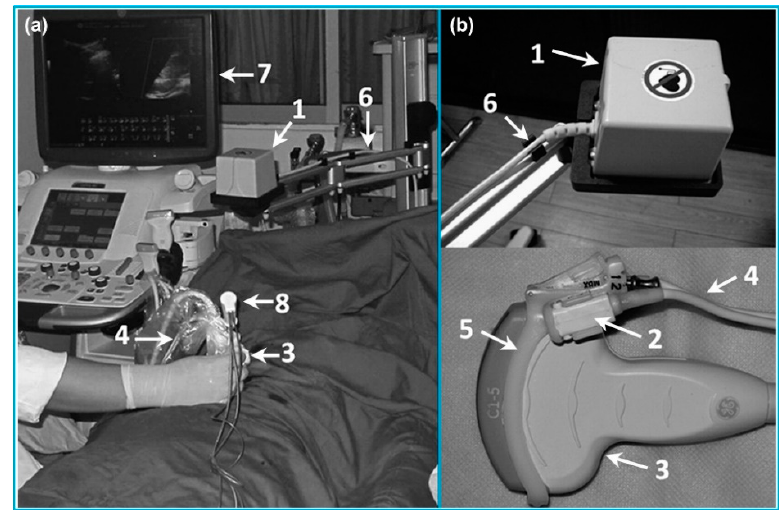
Figure 12. A magnetic navigation system for liver cancer ablation procedures. ( a ) The setup of the magnetic navigation system; ( b ) Magnetic field generator and magnetic receivers attached to an US probe. Reprinted from [162] with permission.